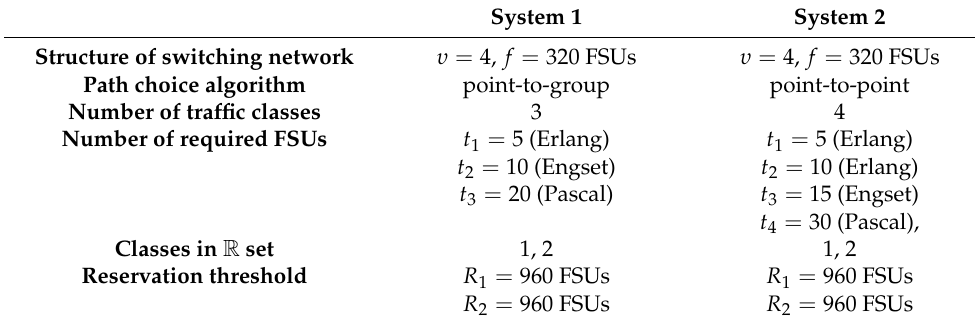
Table 1. Parameters of the systems under investigation.